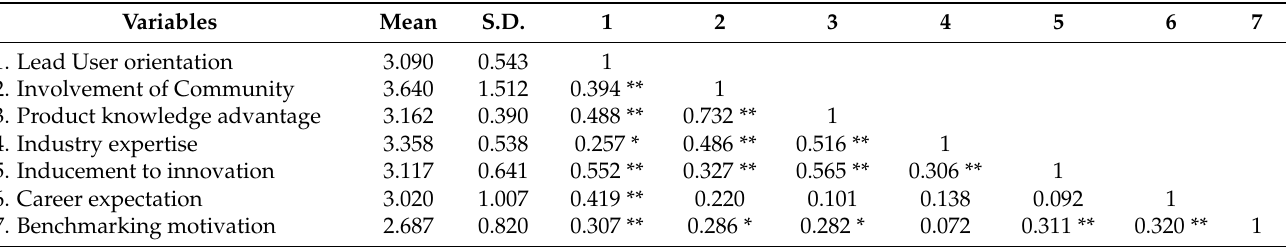
Table 6. Mean, standard deviation, and bivariate Pearson correlations for all variables.